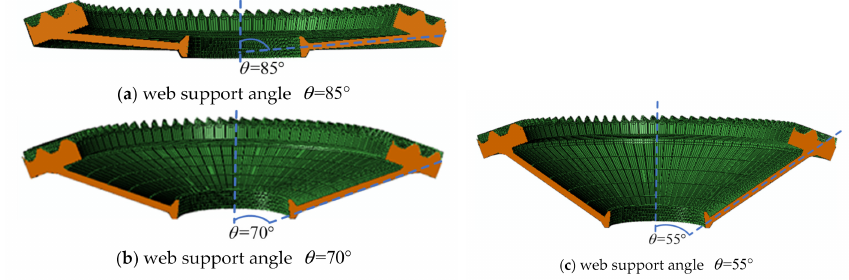
Figure 7. Mesh model with different web support